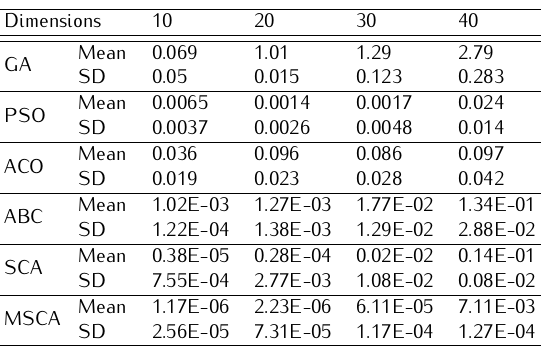
Table A.7. The results of GA, PSO, ACO, ABC, SCA and MSCA for Schwefel